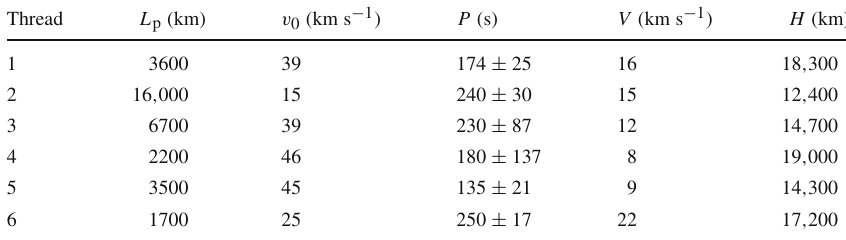
Table 2 Summary of geometric and wave properties of horizontally flowing and vertically oscillating threads analysed by Okamoto et al. (2007) Thread